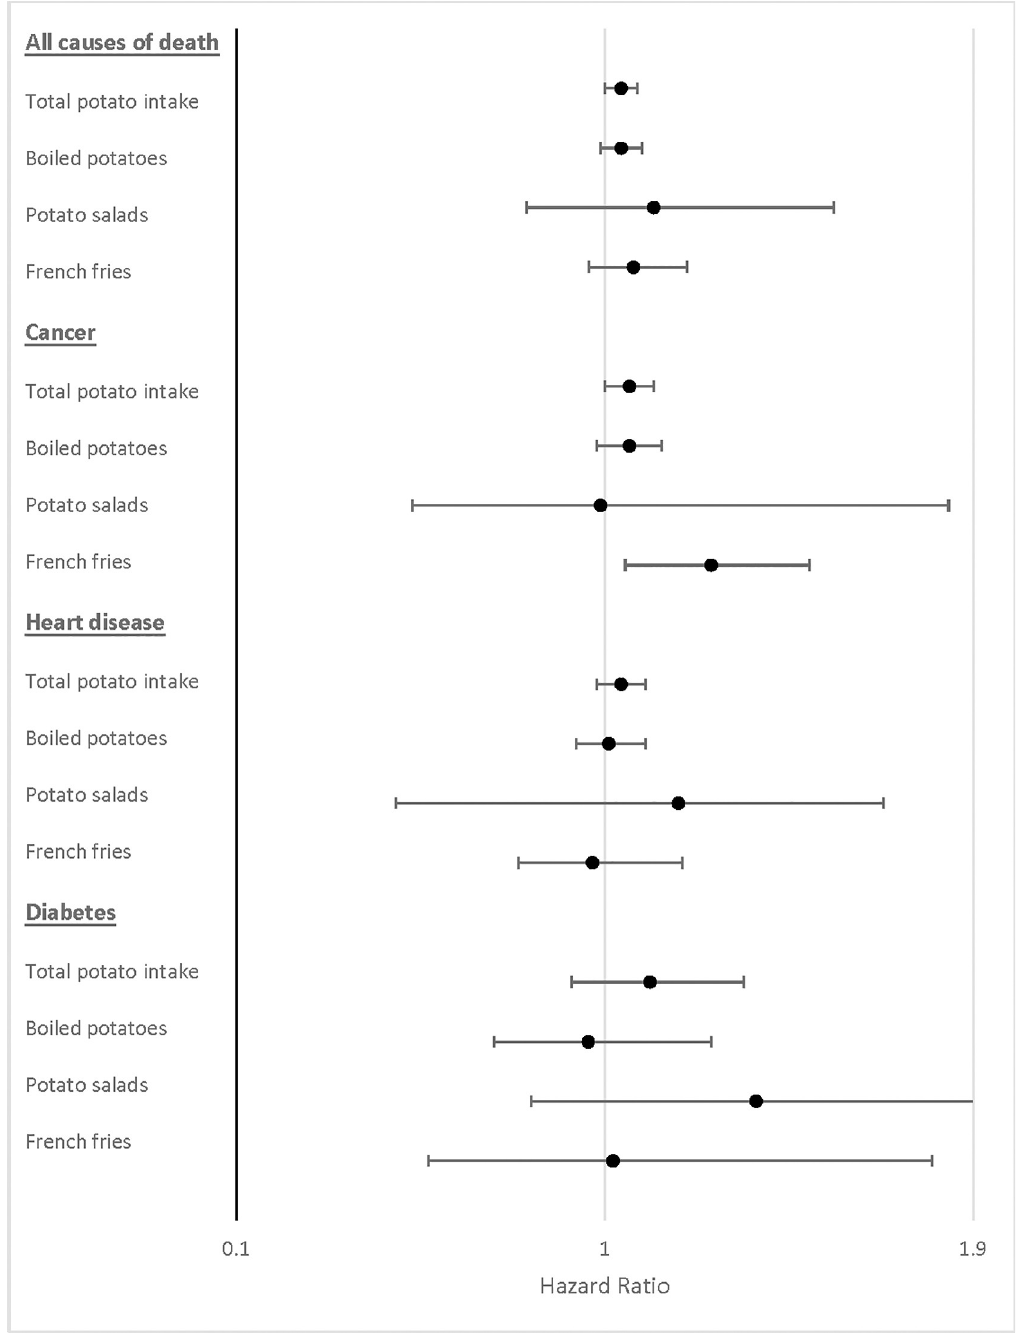
Fig 1. Hazard ratios for overall mortality for different types of potato preparation. Point estimates represent highest ( � 7 times per week) vs. lowest category ( < 1 time per week) of consumption adjusted for age (years), sex (M, F), use or non-use of pipes or cigars, the number of cigarettes smoked per day, time of smoking cessation ( < 1 year, 1 to < 5 years, 5 to < 10 years, or � 10 years before baseline), alcohol drinking (grams per day), ethnicity (non-Hispanic White, non-Hispanic Black, Hispanic, Asian/Pacific Islander/Native American), body mass index (BMI)(kg/m 2 ), education (high school or less, post-high school training, college graduate, post-graduate education), physical activity (never, rarely, 1–3 times per month, 1–2 times per week, 3–4 times per week, � 5 times per week), self-report history of diabetes (yes, no), calories (kcal per day, quintile), red meat intake, white meat intake, whole grain intake, fruit intake, and vegetable intake (grams per day, quintile); HRs (95% CIs) were calculated by using a Cox regression